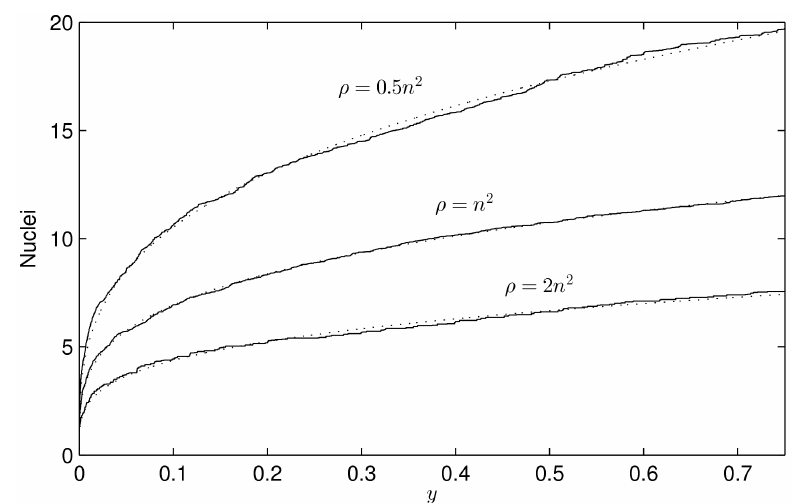
Figure 4. Number of crystallization nuclei along the process, from the beginning ( y = 0) to 75% of total occupied area ( y = 0.75), for different values of ρ . We represent (solid lines) the means of 100 simulations for ρ = 0.5 n 2 , ρ = n 2 , and ρ = 2 n 2 respectively, with n = 256 and C ( i , j ) . The rest of the parameters are β = 1, α = 0.8, and r shown (dotted lines) that the number of crystallization nuclei follows a power law of the form ay b with a = 21.41, b = 0.3083 ( ρ = 0.5 n 2 ), a = 12.98, b = 0.2722 ( ρ = n 2 ), and a = 8.006, b = 0.2628 ( ρ = 2 n 2 ). Note that parameter a represents the expected number of nuclei at the end of the process ( y = 1) and, from this result, it seems to hold a 1 ≈ 1.635 a 2 for ρ 1 = 1